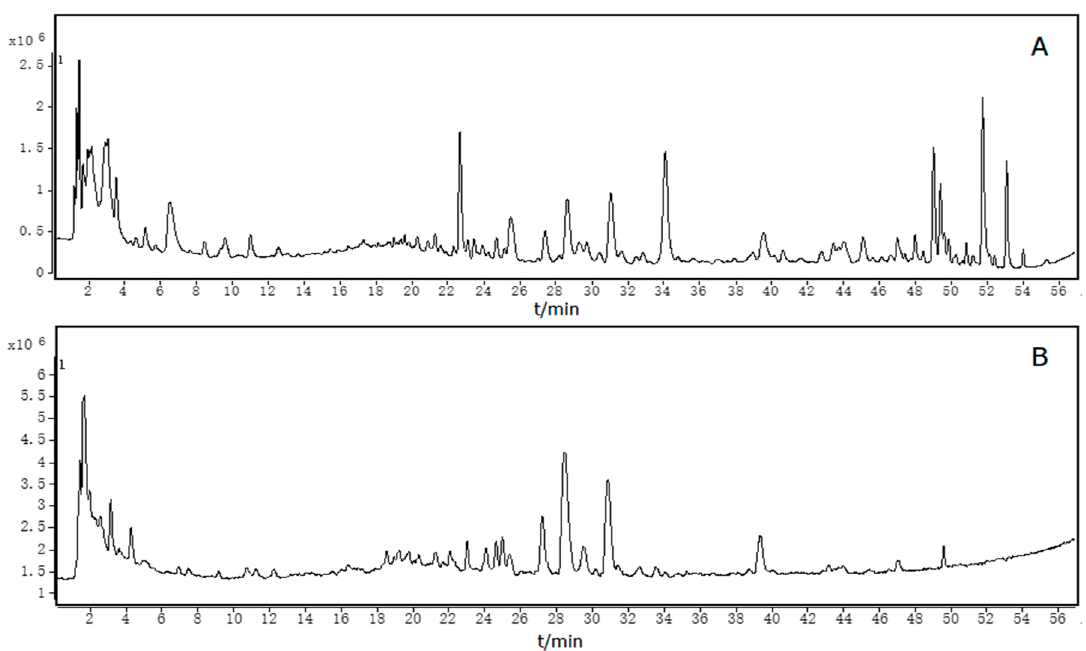
Figure 2. Total ion chromatography of Simo decoction (SMD) in positive ( A ) and negative ( B ) modes.